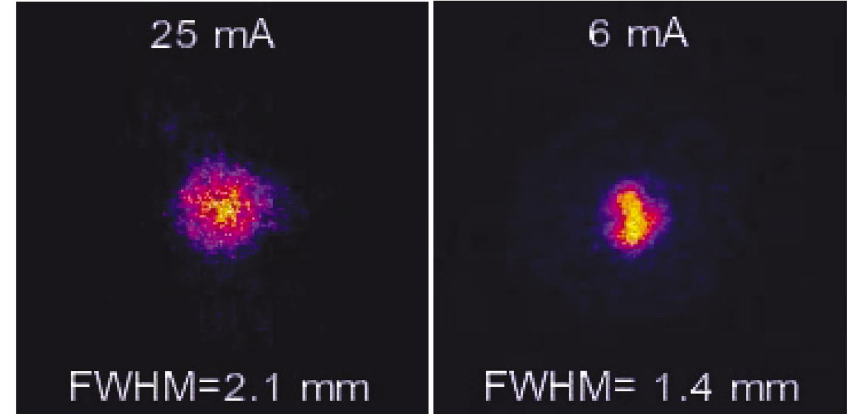
FIG. 14. (Color) Spot size dependence on